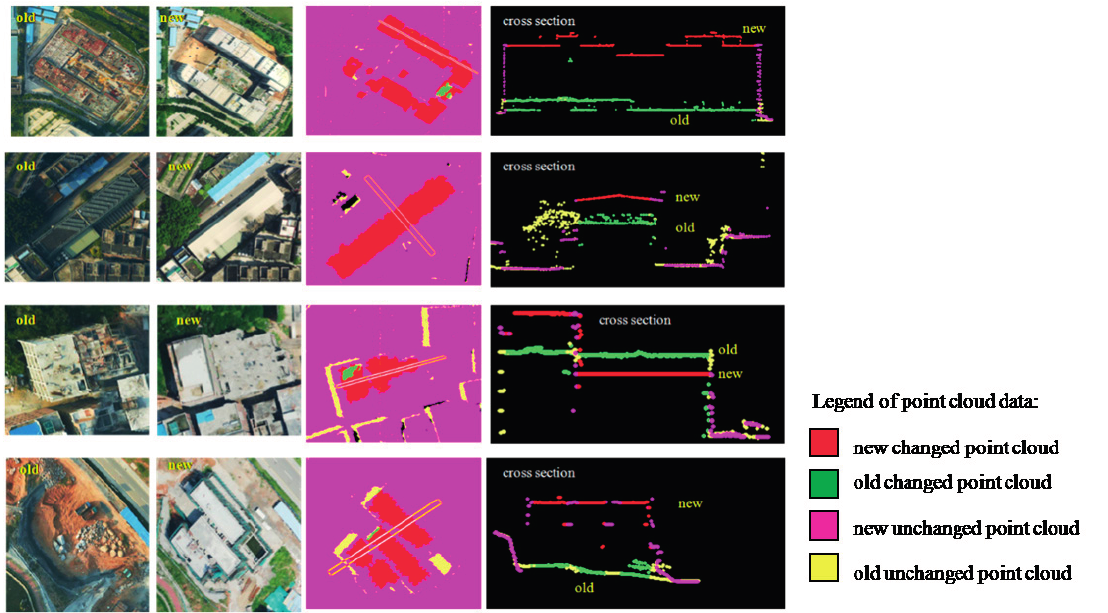
Figure 6. Examples of the results ( first column : old orthophoto; second column : new orthophoto; third column : superposition of the old and new point clouds; fourth column : cross-section of the yellow rectangle area in the third column; fifth column : legend of the point cloud data).